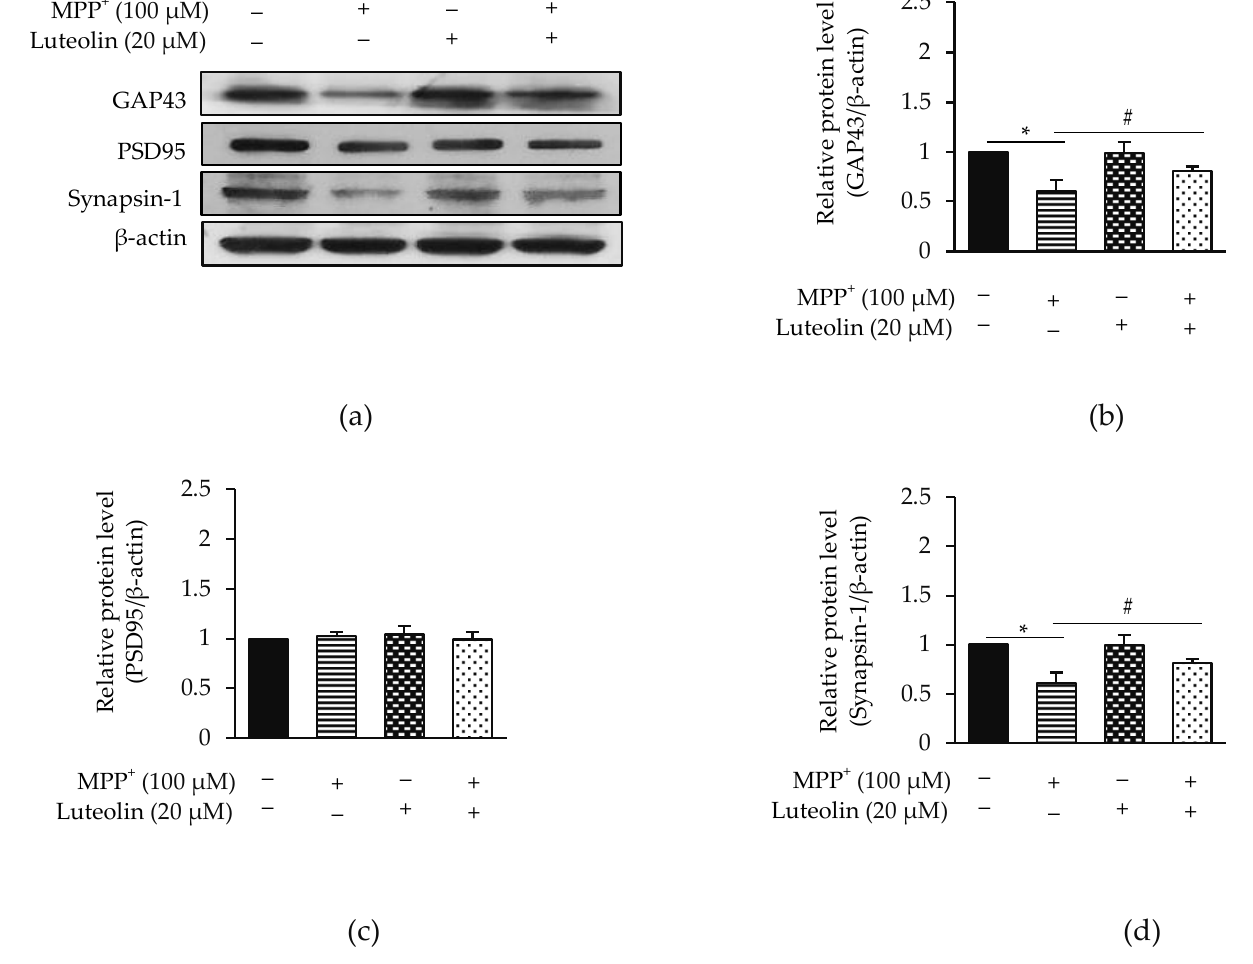
Figure 3. Luteolin prevented MPP + -suppressed synaptic communication in SH-SY5Y cells. Cells were pre-treated with 20 µ M luteolin for 1 h followed by treatment with 100 µ M MPP + for 24 h. ( a ) Expressions of GAP43, PSD95 and synapsin-1 were detected by western blot analysis. Bar graph represents ( b ) GAP43, ( c ) PSD95 and ( d ) synapsin-1 expression levels. Data were normalized using β -actin as control. Results are shown as the mean ± SD for triplicated independent experiments. Differences are statistically significant at * p < 0.05 versus the control group, and # p < 0.05 versus the MPP + group.